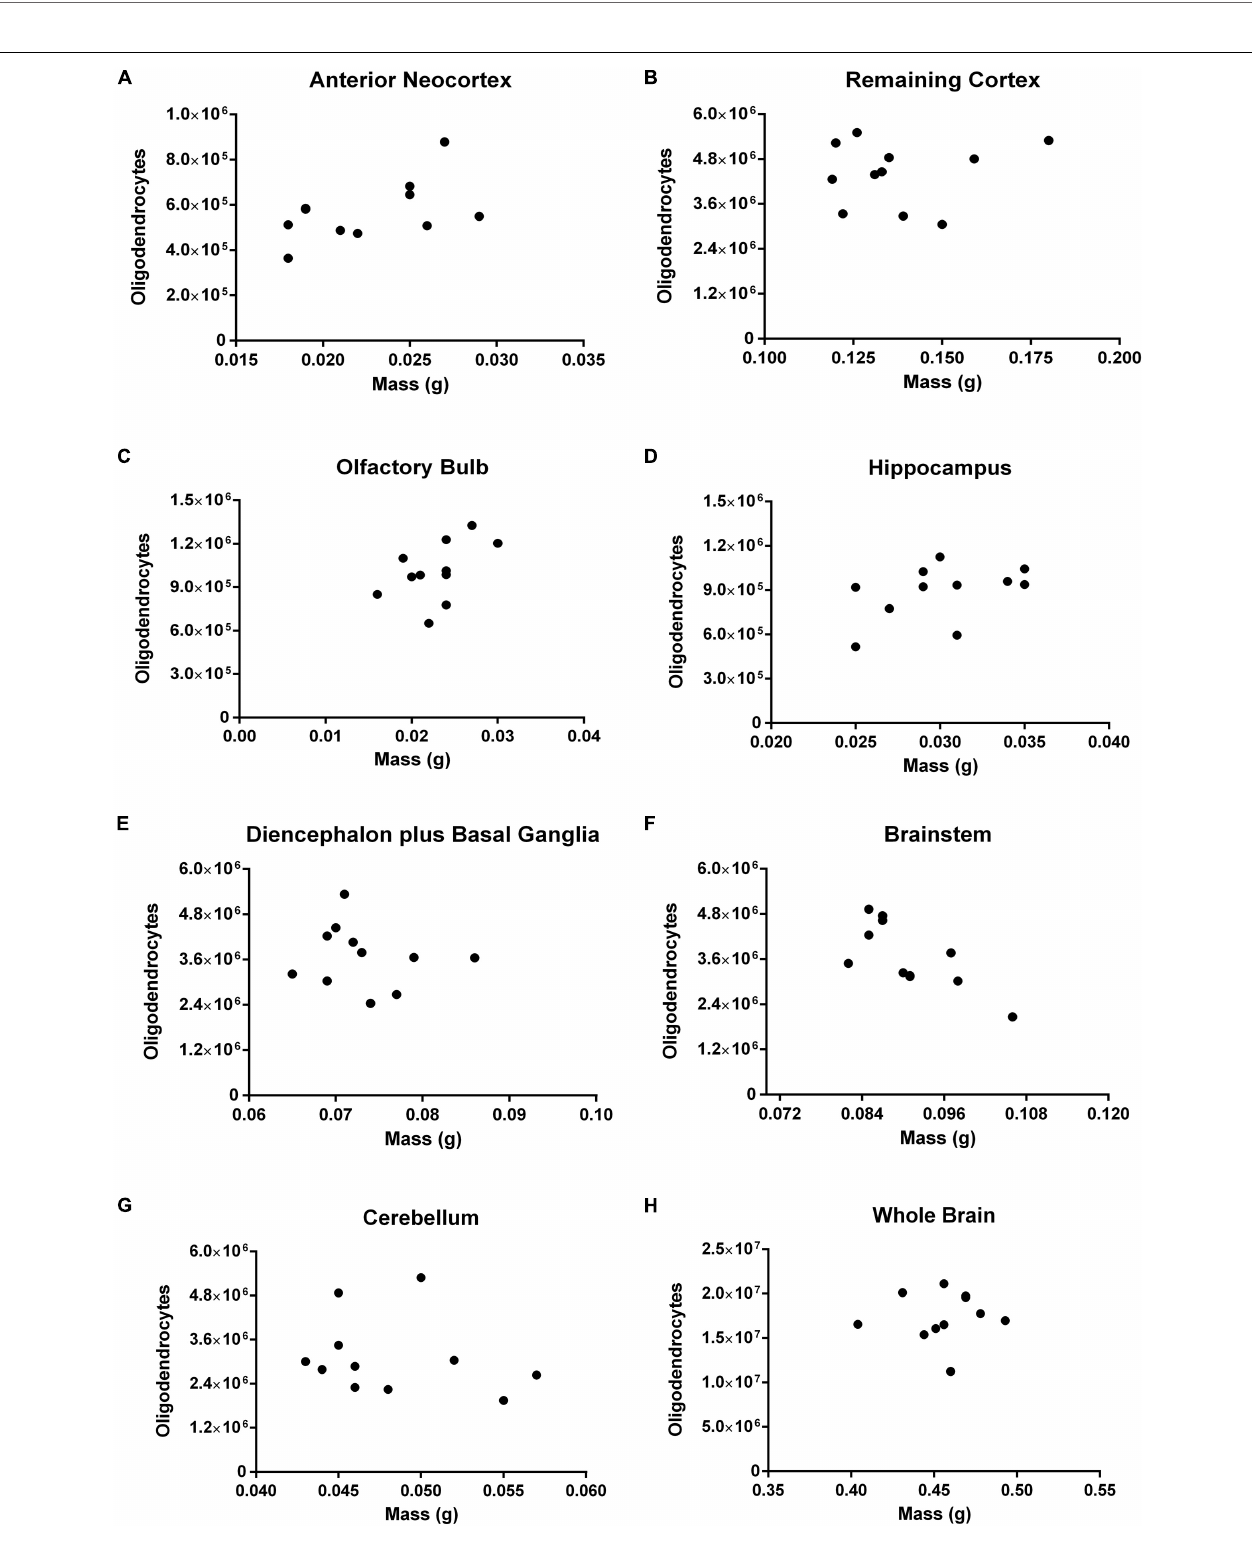
FIGURE 8 | Spearman’s correlation between the absolute number of oligodendrocytes and mass. Dissected regions are shown from (A–G) . The data for the whole brain is displayed in (H) . (A) Anterior Neocortex: rho = 0.4302, p = 0.1868. (B) Remaining Cortex: rho = 0.0090, p = 0.9895. (C) Olfactory Bulb: rho = 0.5257, p = 0.0999. (D) Hippocampus: rho = 0.5505, p = 0.0863. (E) Diencephalon plus Basal Ganglia: rho = –0.2642, p = 0.4215. (F) Brainstem: rho = –0.7369, p = 0.0108. (G) Cerebellum: rho = –0.3196, p = 0.3283. (H) Whole Brain: rho = 0.1553, p = 0.6472. Each dot represents one animal ( n =